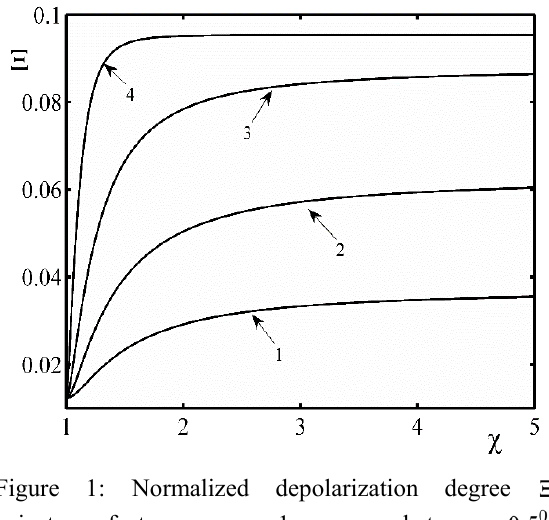
1: Normalized depolarization degree anisotropy factor ; curve 1 corresponds to , curve 2 - , curve 3 - , curve 4 -